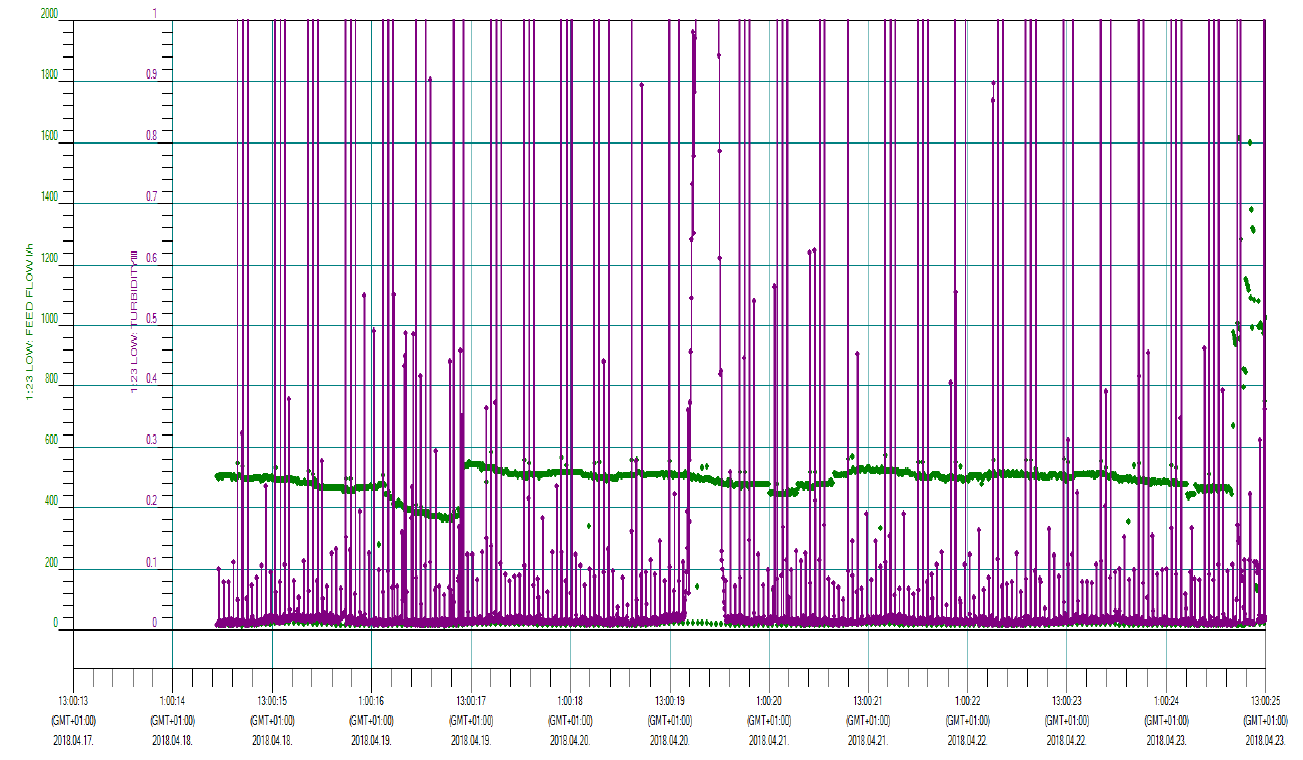
Figure A2. Flow and temperature.